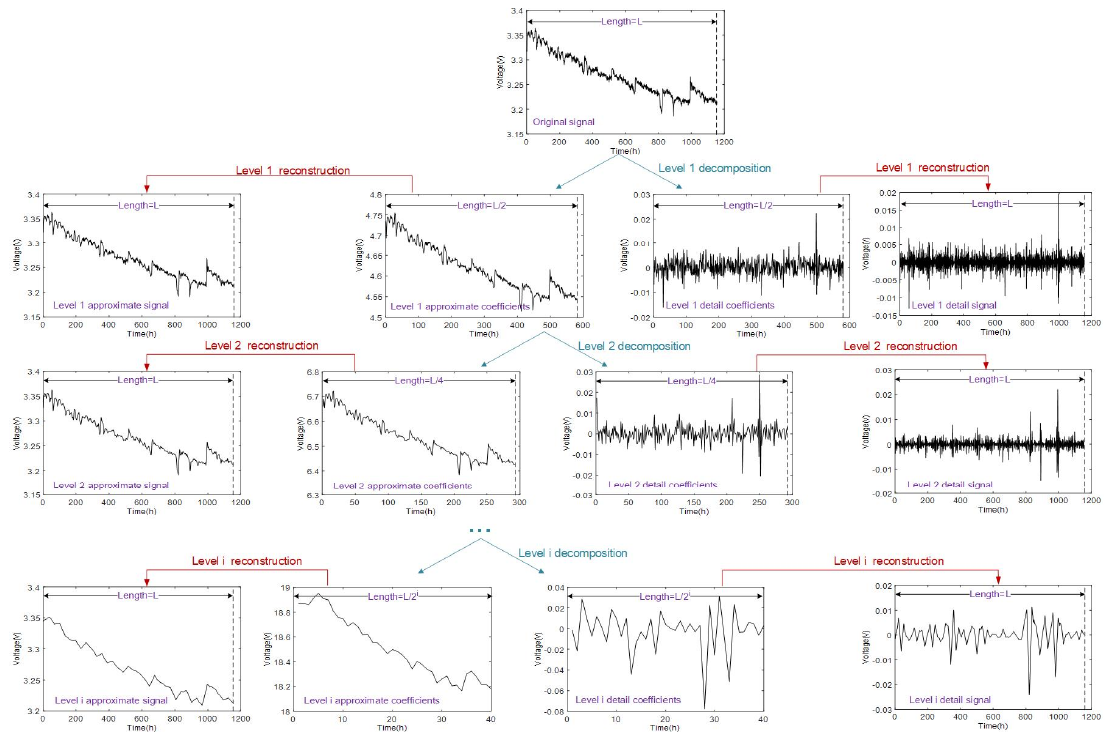
Figure 4. Decomposition and reconstruction process of DWT.